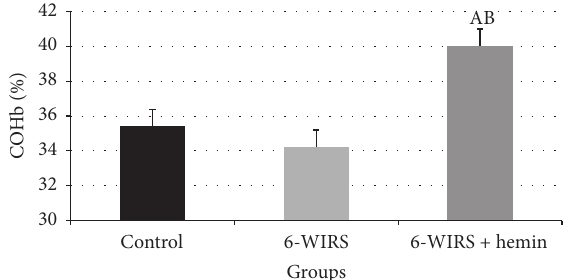
Figure 1: Effect of water immersion restraint stress (WIRS) with or without hemin on carboxyhemoglobin level in male albino rats. A Significant difference from the control group and B significant difference from the WIRS group, 𝑝 ≤ 0.05. Values are expressed as mean ± SEM of 10 rats in each